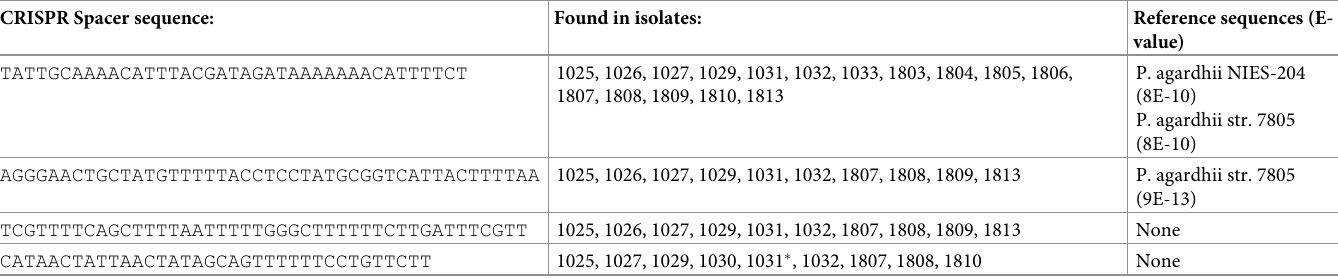
Table 4. Table of common CRISPR spacer elements across a majority of isolates ( � 10). CRISPR Spacer sequence: Found in